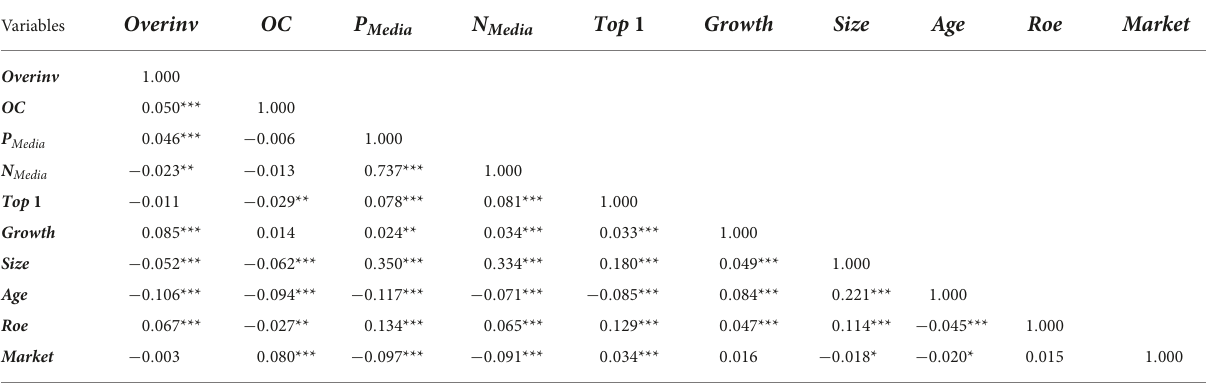
TABLE 3 Correlation coefficient test table.